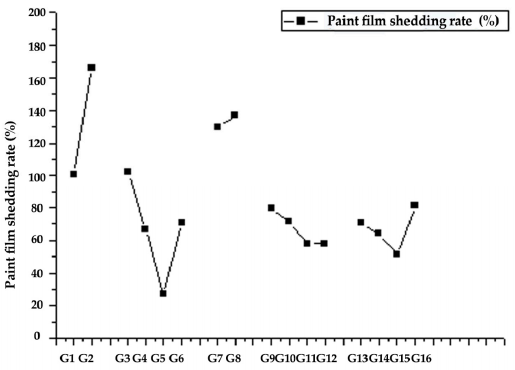
Figure 4. Change trends of factors and levels for the effect of adhesion of paint